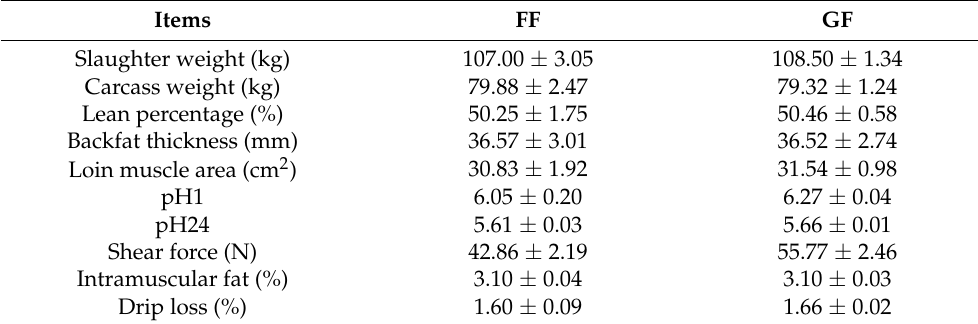
Table 1. Characteristics of carcass and meat quality traits under different rearing conditions in Heigai pigs. Items FF GF Slaughter weight (kg) 107.00 ± 3.05 108.50 ± 1.34 Carcass weight (kg) 79.88 ± 2.47 79.32 ± 1.24 Lean percentage (%) 50.25 ± 1.75 50.46 ± 0.58 Backfat thickness (mm) 36.57 ±